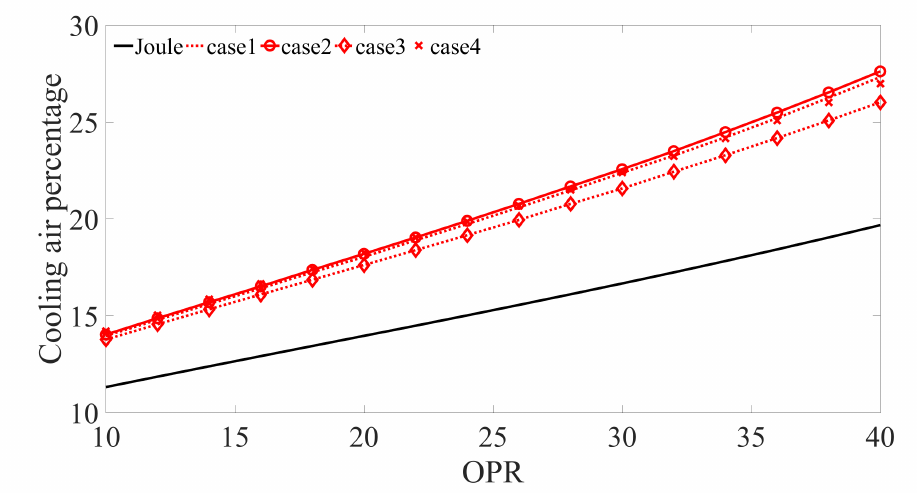
Figure 10. Percentage of compressor outlet air used for turbine cooling. TIT: 1700 ◦